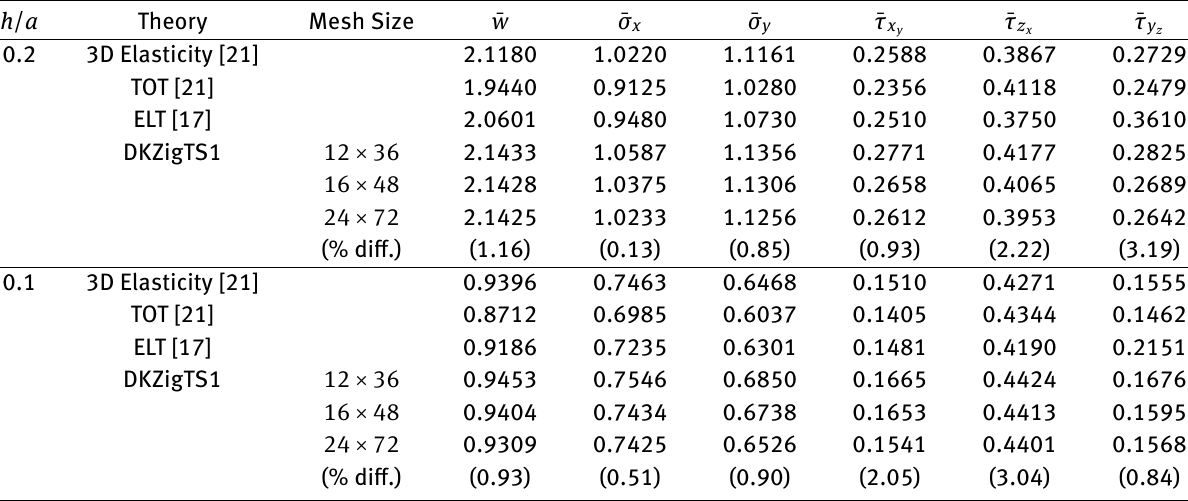
Table 10: Non-dimensionalised deflection and stresses for an all-round simply supported rectangular a composite cylindrical shell panel ‘A’ with b / a = 3 and R / a = 4 under sinusoidally distributed load h /